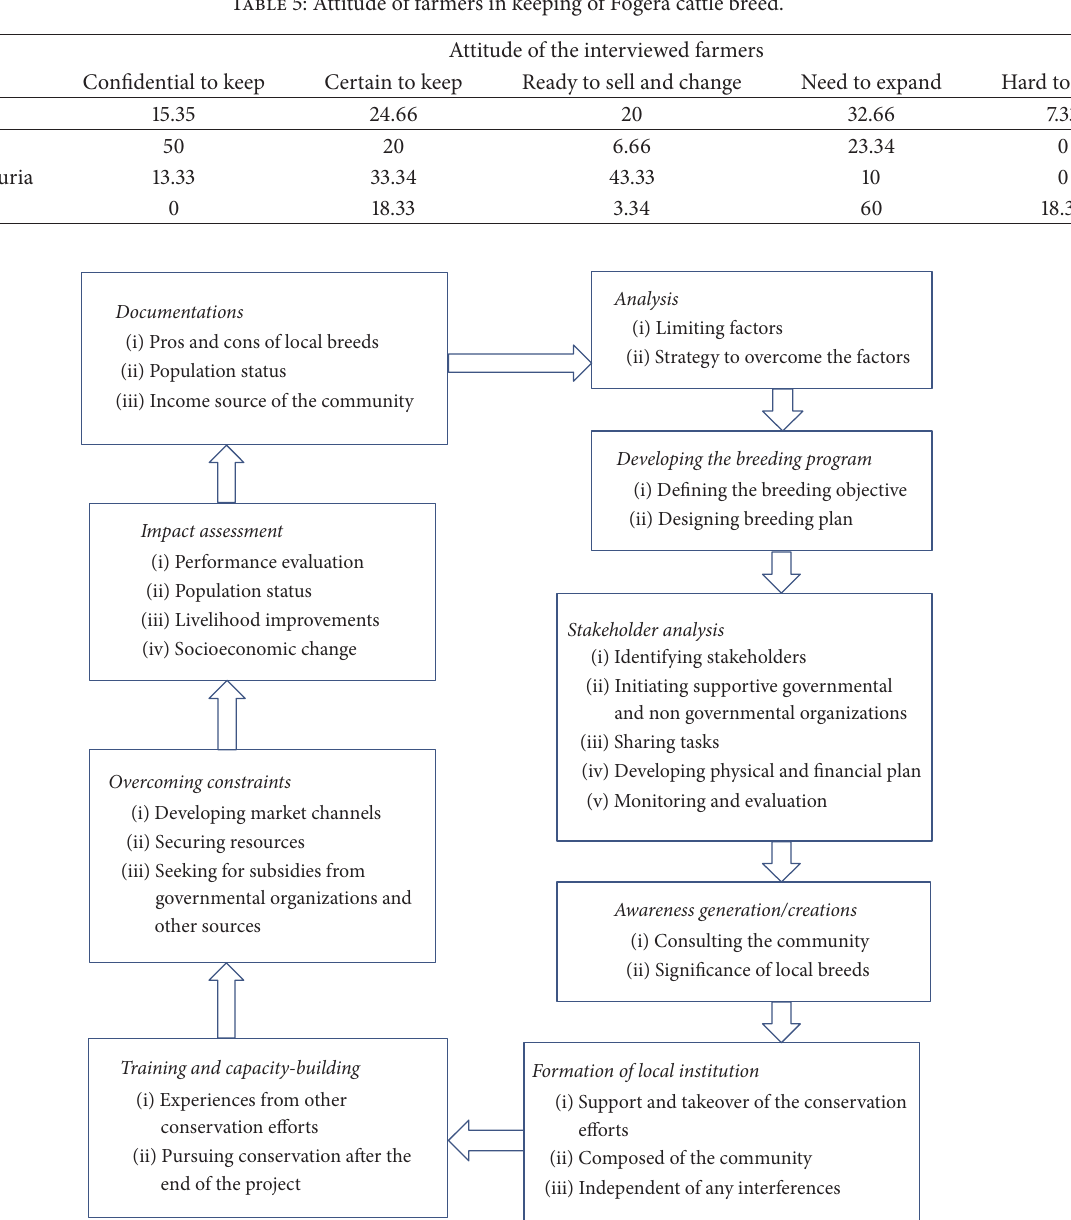
Table 5: Attitude of farmers in keeping of Fogera cattle breed.